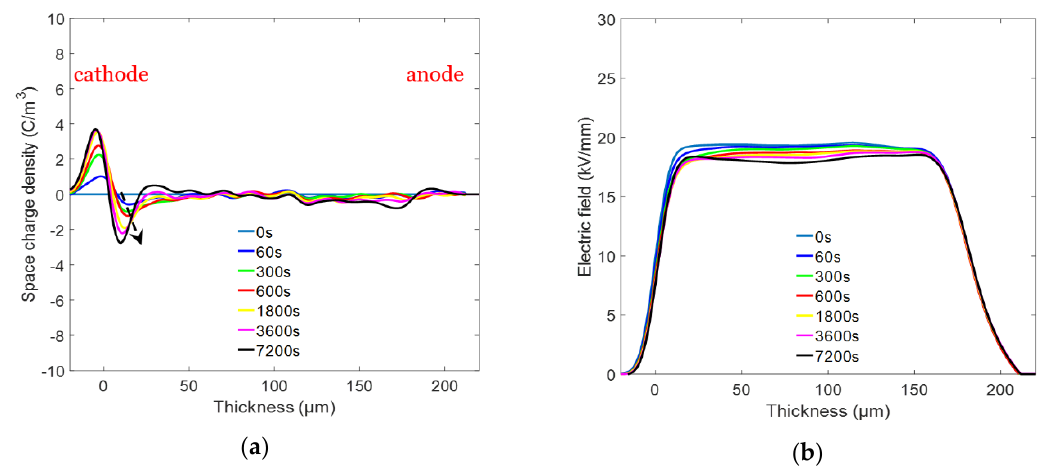
Figure 6. ( a ) Space charge behaviour in degassed XLPE samples at 20 kV / mm field (capacitive charge removed). ( b ) Electric field distribution across the degassed XLPE film.